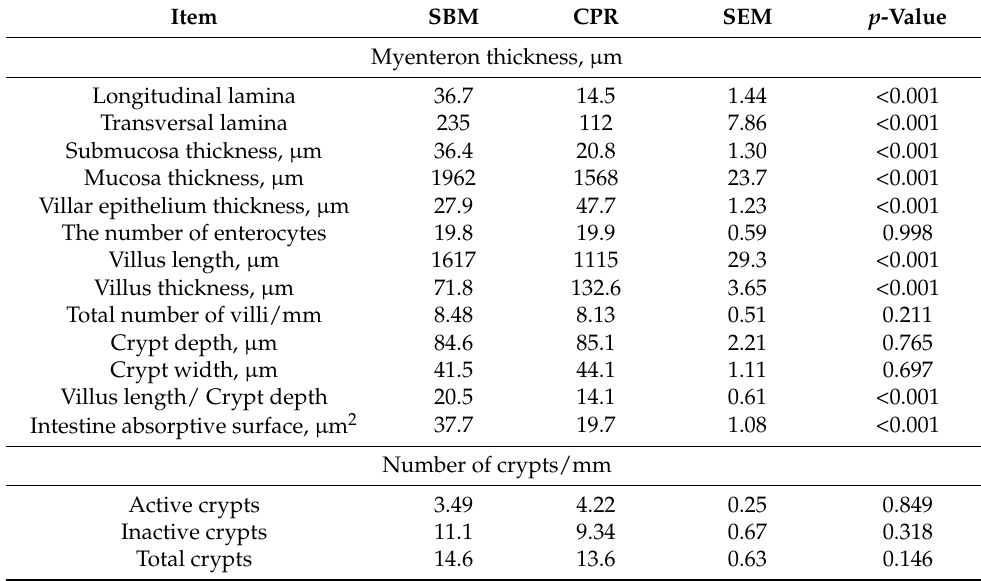
Table 3. Effect of raw chickpea on histomorphometric parameters of the jejunum in 42-day-old broiler chickens 1